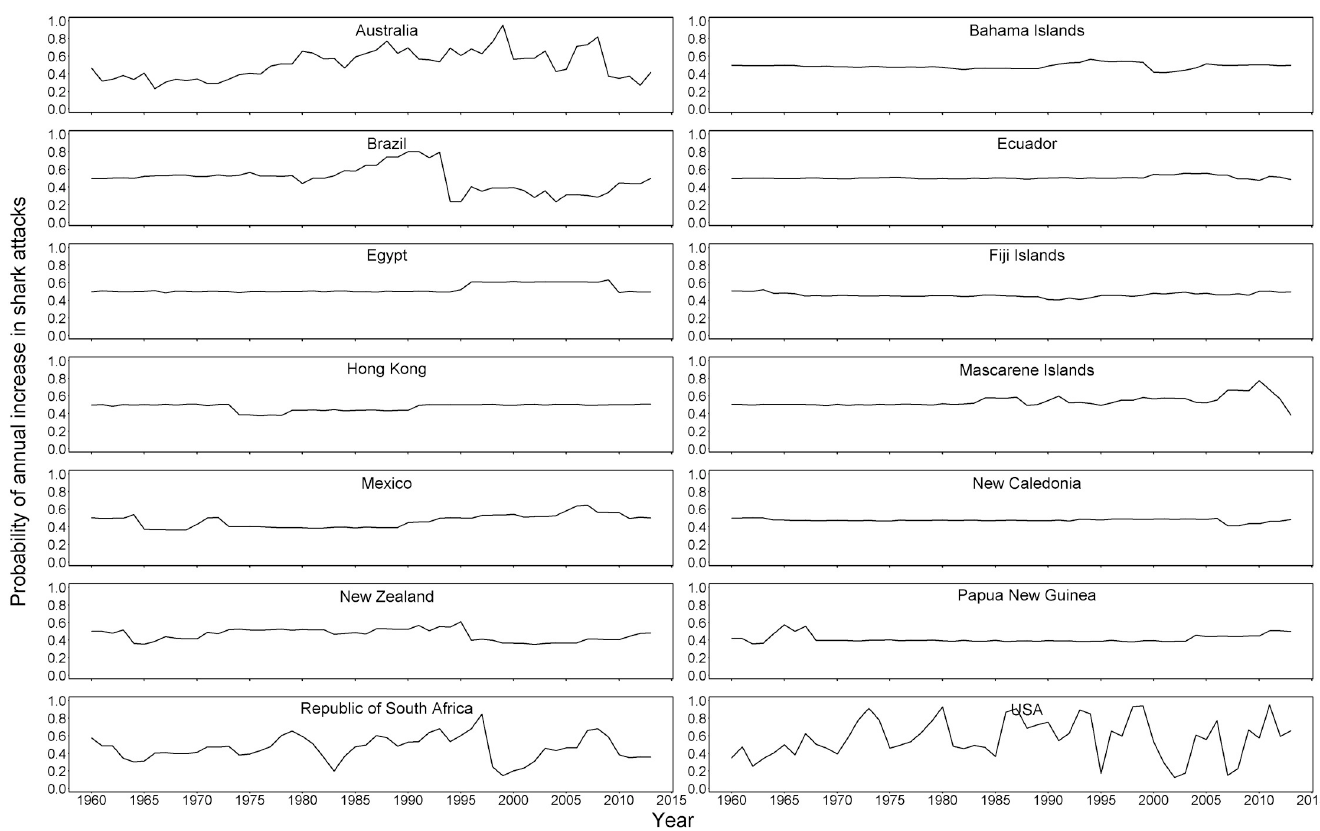
Fig 3. Annual probabilities of an increase in shark attack rate from 1960–2015 for the 14 countries with the most shark attacks during this time.